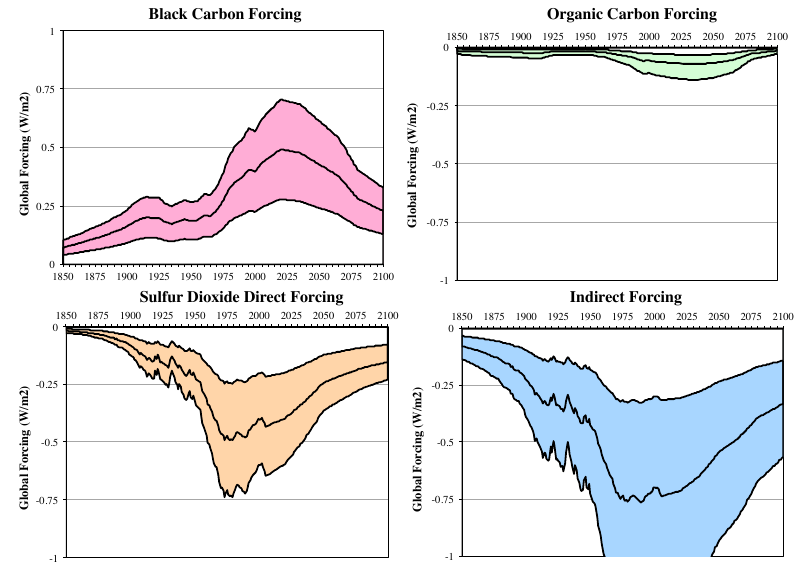
Fig. 3. Radiative forcing ranges for black carbon, organic carbon, sulfate aerosol, and indirect cloud forcing estimated by combining historical emissions estimates plus future emissions under the reference case